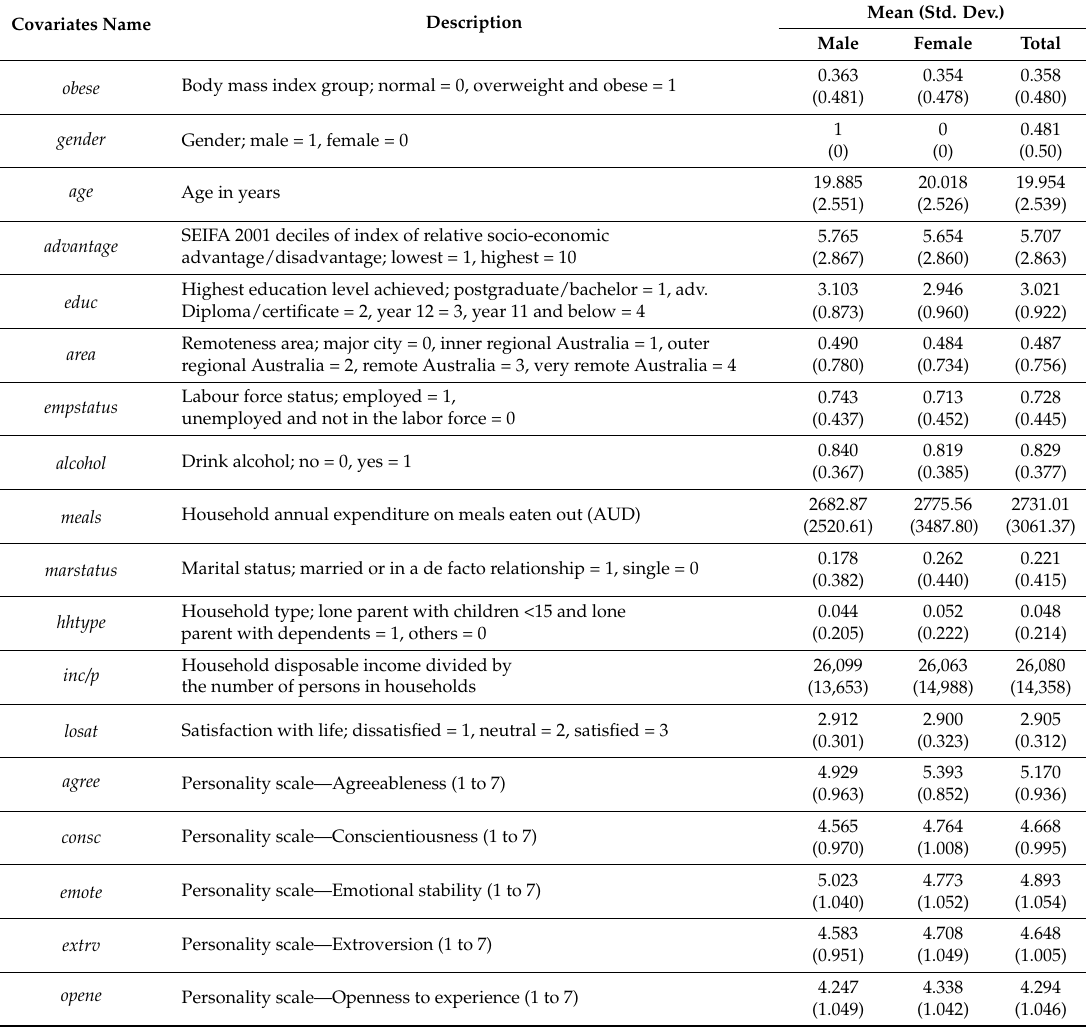
Table 2. Description and Descriptive Statistics for the Covariates Used in the